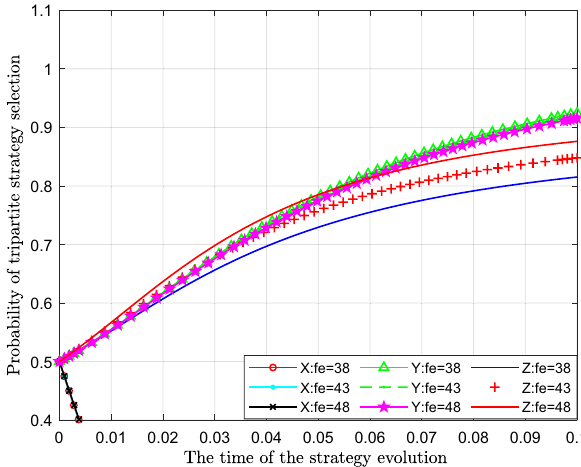
Figure 7. Effect of the change in penalty for excessive emissions.